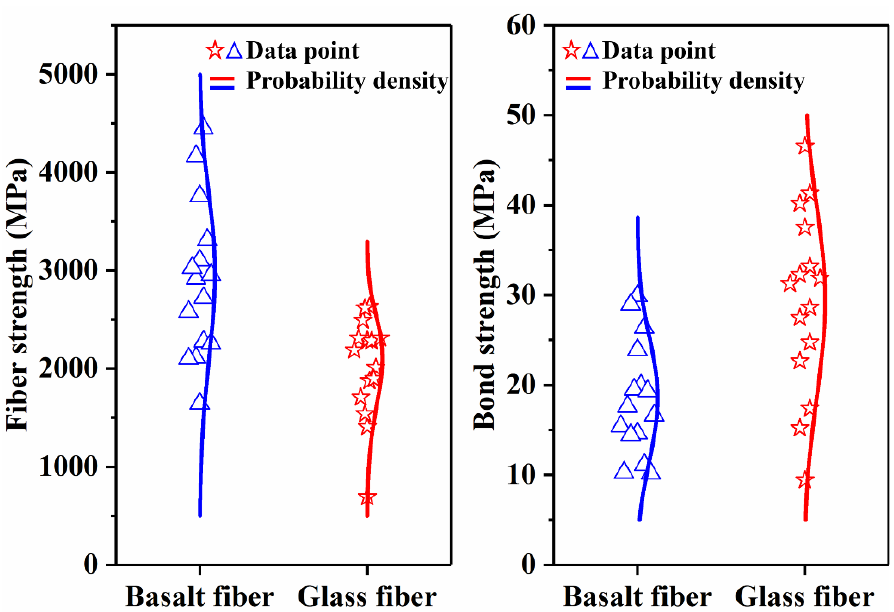
Figure 6. Fiber strength and interface strength comparison.